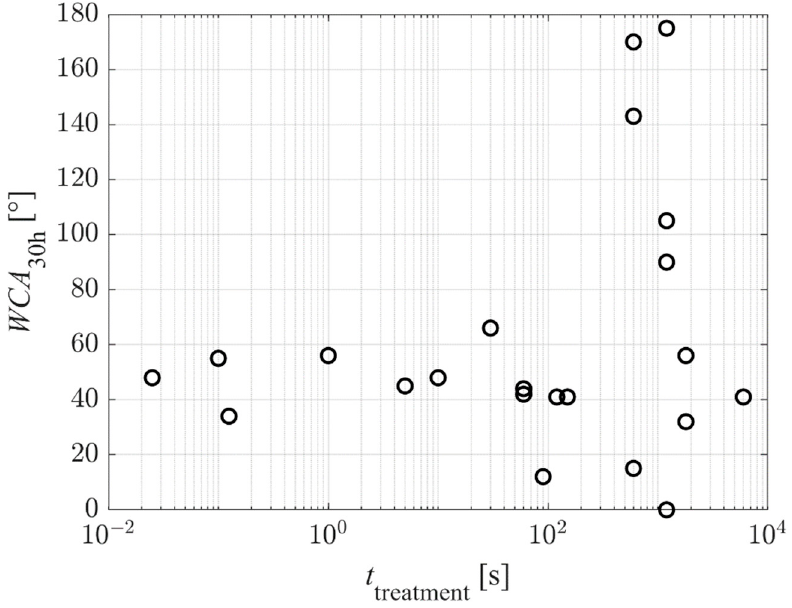
Figure 11. The WCA of PET samples after aging for 30 h versus the plasma treatment time.